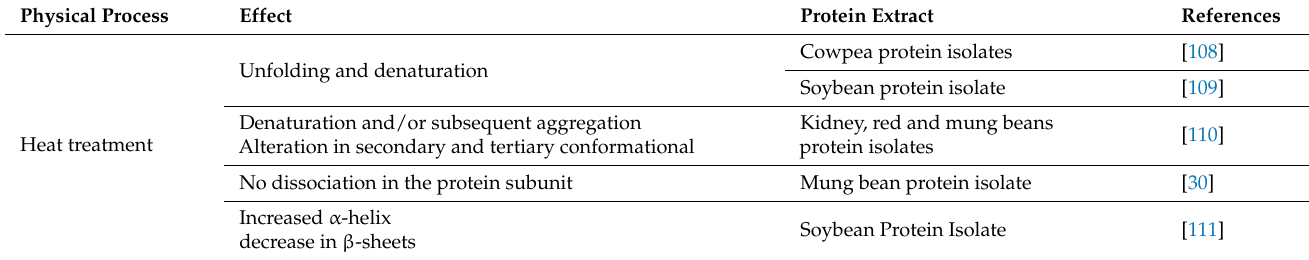
Table 2. Effect of processing on the structure of legume protein